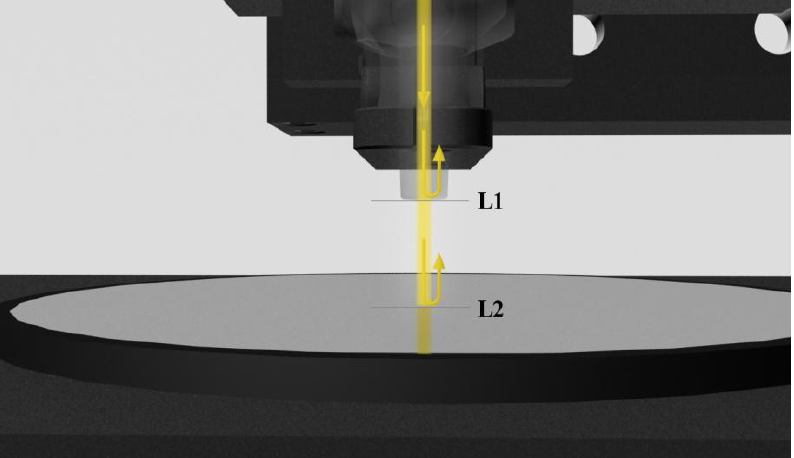
Figure 1. The construction of fiber-optic Fabry-Perot interferometer: L1, L2—the first and second reflective layers,